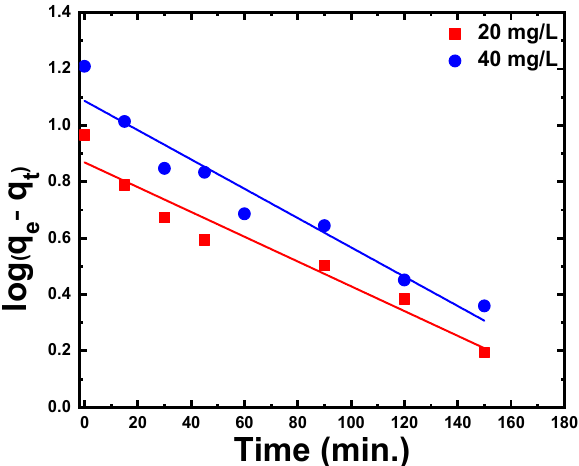
Figure 6. Pseudo-first-order kinetic model (log( q e − q t ) versus time) for CR dye adsorption on the ZnS nanoparticles.